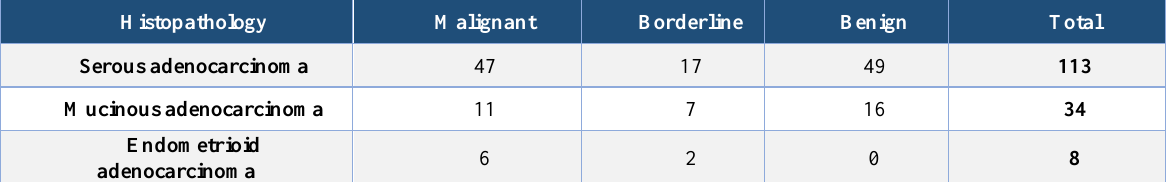
Table 2. The 1.5% Gel Electrophoresis of HPV type 16 and 18 PCR products, using type-specific primers. C+: positive control; C–: Negative control; Lanes: 1 and 2 (a positive